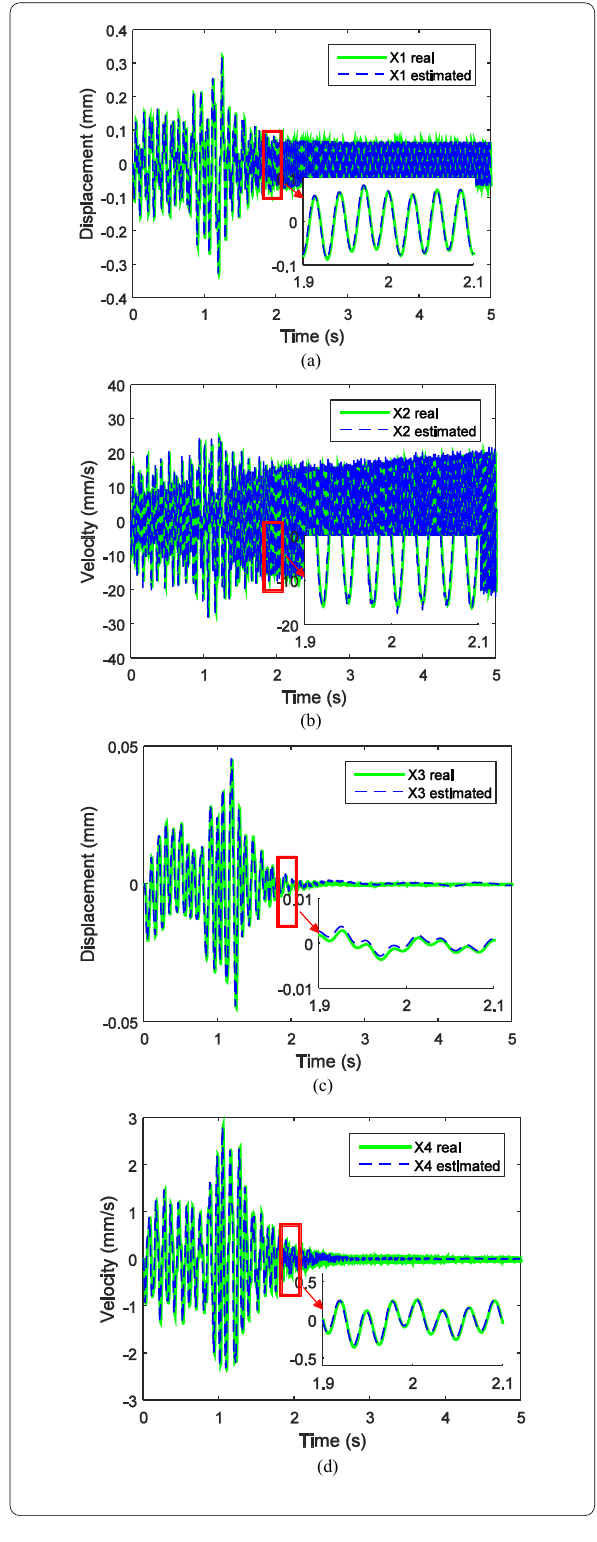
Figure 14 Comparison between estimated system state and real system state under variable engine speed condition (engine speed increased from 750 r/min to 2100 r/min): a X 1 : engine displacement, b X 2 : engine velocity, c X 3 : sprung mass displacement, and d X 4 : sprung mass velocity